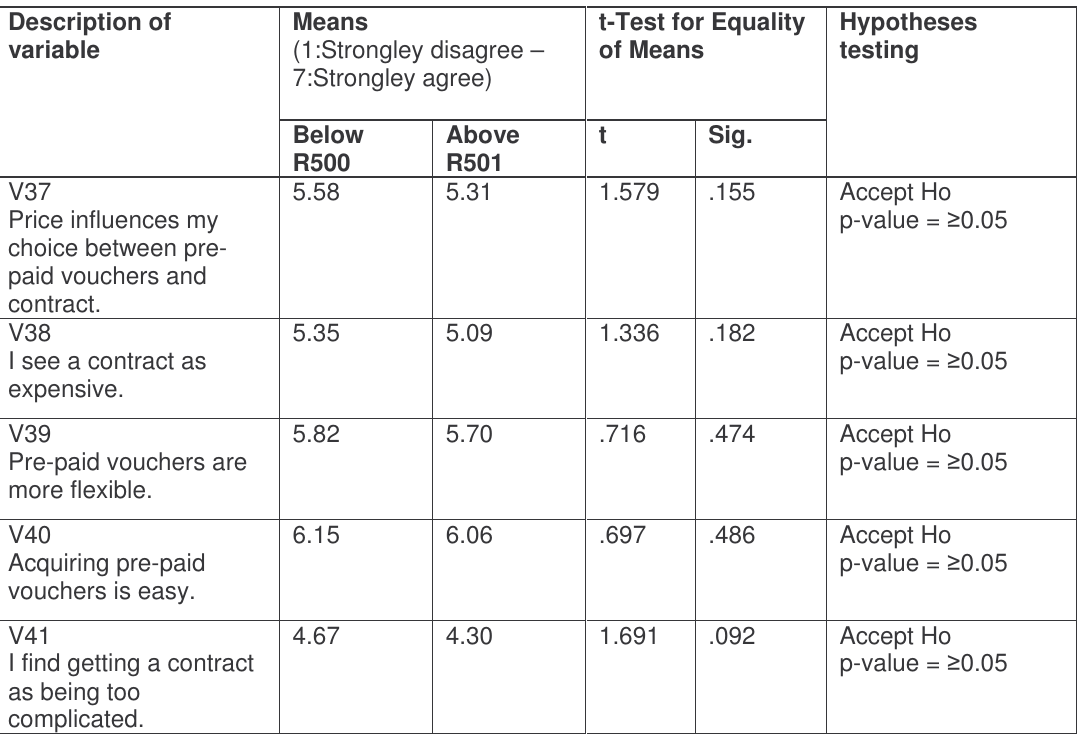
Table 1: t-Test results for students’ (with a monthly income up to R500 and monthly income of R501 and more) preference of pre-paid versus contract. Means (1:Strongley disagree